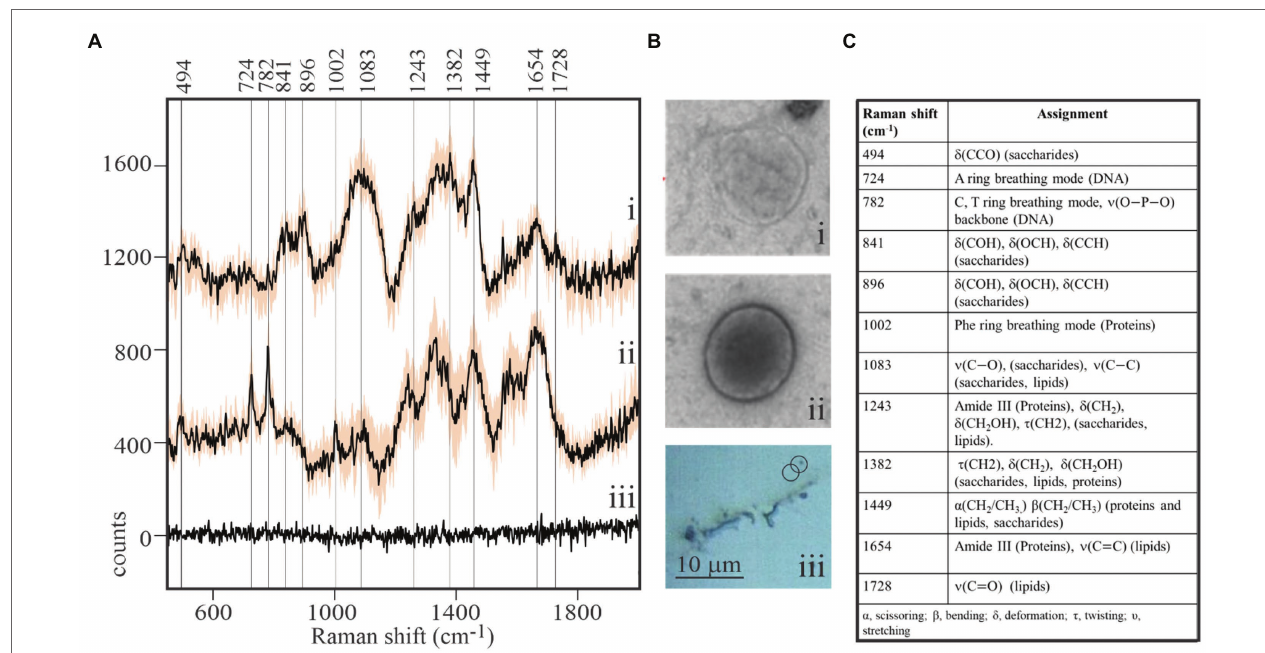
FIGURE 2 | Macromolecular composition of viral-like particles. (A) Stacked spectra from purified, formaldehyde-fixed EhV-163 viral preparations illustrating differences between empty structures (i) and complete virions (ii). Spectra are means from five viral-sized targets and shaded area represents one standard deviation (±1 SD) about the mean observed at each wavenumber. The absence of diagnostic peaks for DNA (724 and 782 cm − 1 ) and Phe (1,002 cm − 1 ) and presence of lipid peaks (1,382 and 1,449 cm − 1 ) in (i) suggest targets were empty envelopes or extracellular vesicles. Spectra from the stainless steel slide surface were obtained from areas devoid of virions and illustrate negligible background contributed by the substratum (iii). (B) Examples of transmission electron microscopic (TEM) images of an individual empty structure (i) and individual complete EhV-163 virion (ii) prepared from replicate samples. (iii) Reflected bright-field micrograph of areas on slide with virion aggregates and individual virions. (C) Raman shift assignments reported for specific bonds and molecules (Movasaghi et al., 2007).